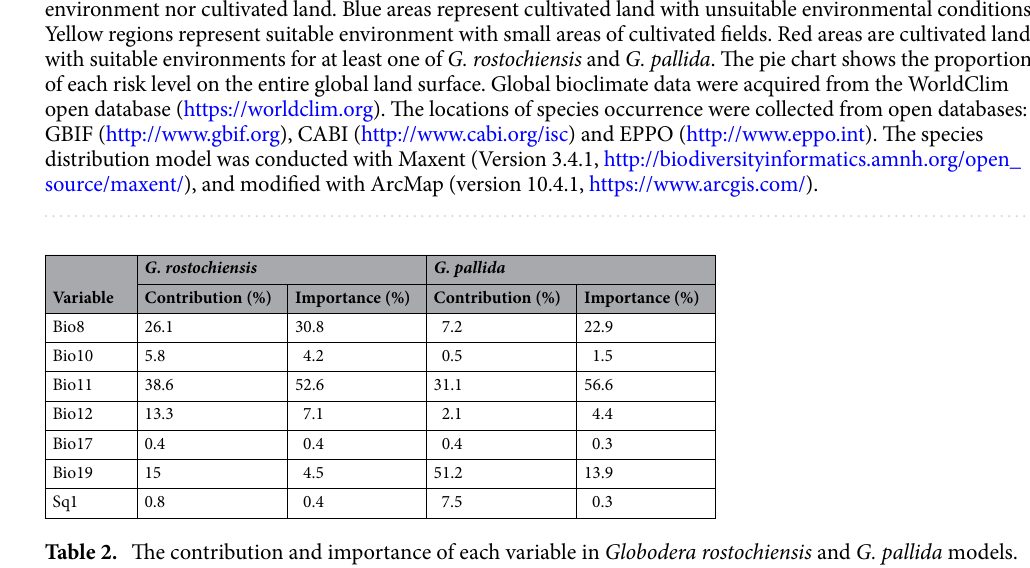
Table 2. The contribution and importance of each variable in Globodera rostochiensis and G. pallida models.